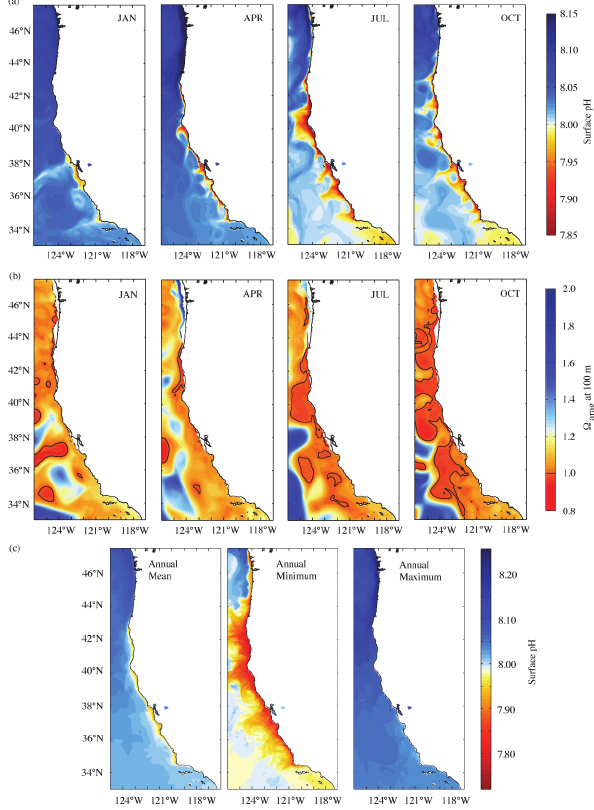
Fig. 7. Simulated monthly averages of (a) surface pH and (b) (cid:127) arag at 100m. Shown are January, April, July and October of model year 2011 ( ∼ 395 ppm atmospheric p CO 2 ). (c) Mean, minimum and maximum values of surface pH from two-day model output.